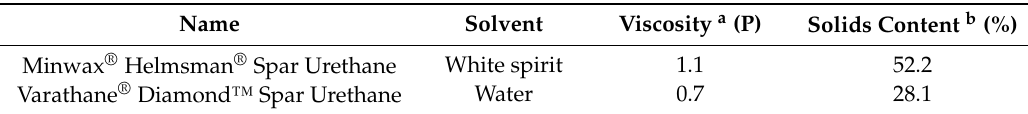
Table 2. Properties of the polyurethane coatings that were applied to plasma-modified black spruce